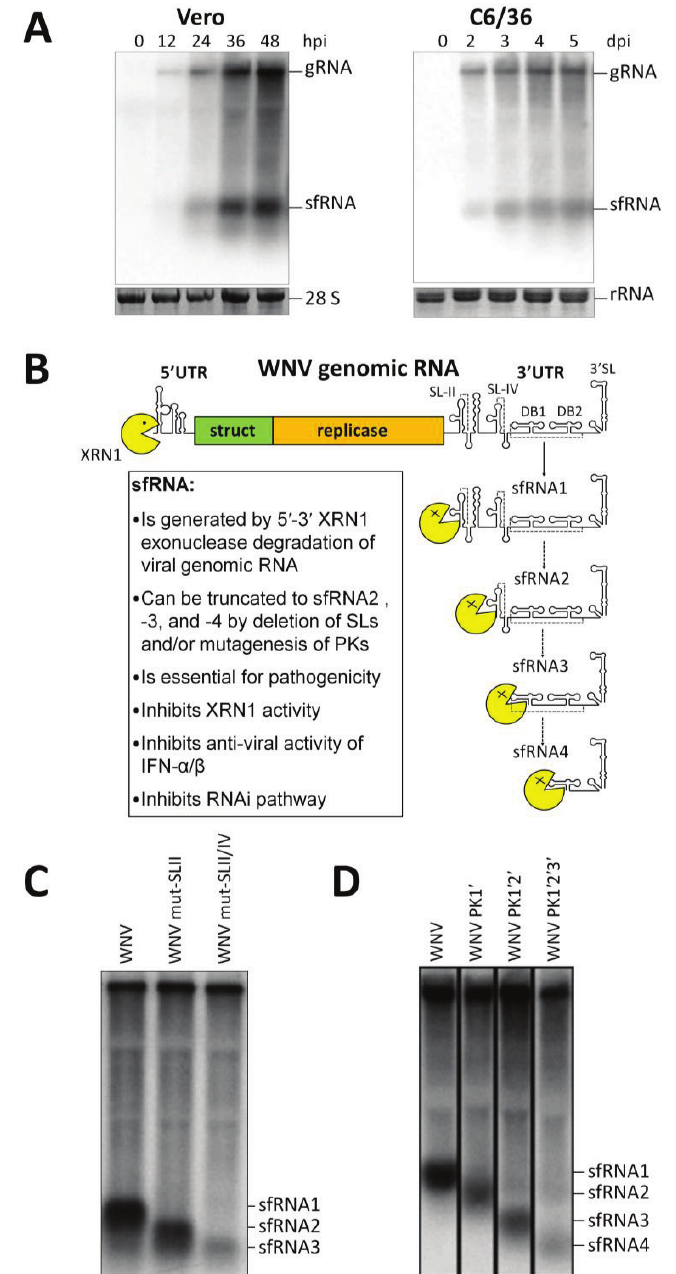
Figure 3. sfRNA is generated by XRN1 stalling at conserved SL and PK structures. ( A ) Northern blot detection of WNV sfRNA accumulation over the course of infection in mammalian (Vero) and mosquito (C6/36) cell lines using oligonucleotide probes complementary to the 3'SL [19]; ( B ) Schematic representation of the mechanism of sfRNA generation. Following decapping or upstream cleavage within the flavivirus gRNA, host XRN1 degrades 5' – 3' stalling at the SL-II/PK1 structure and thus forming sfRNA1 and becoming inactive by association with this moiety. Mutation to delete/disrupt SL ( C ) or PK ( D ) structures leads to downstream XRN1 stalling and accumulation of successively smaller sfRNA species. Modified from Pijlman et al. , 2008 [18] and Funk et al. , 2010